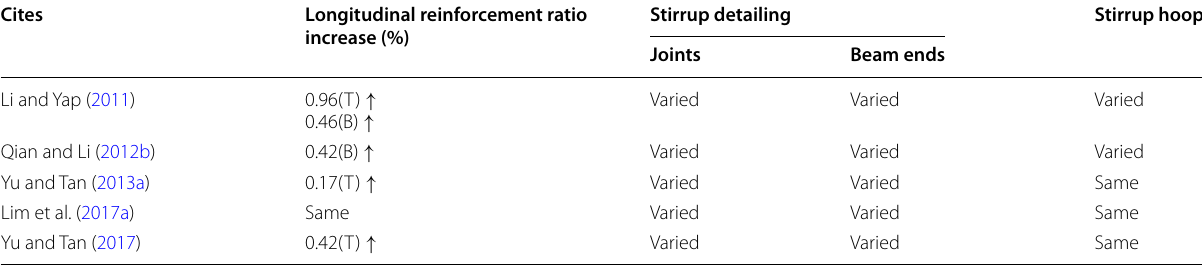
Table 2 Comparison of variables in experiments investigating seismic detailing.